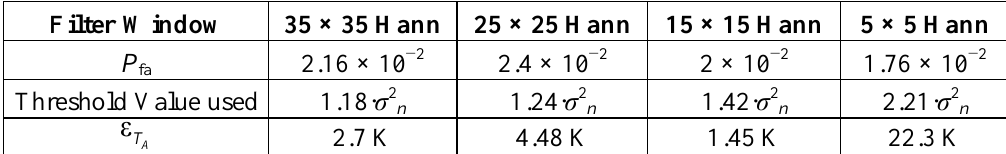
Table 4. Retrieved T error for the threshold used in Figure 15 for the four different cases A of Smoothing Algorithm filtering, with a INR value of −5 dB (equivalent to 126.5 K of interference); for the OFDM interfering signal case.